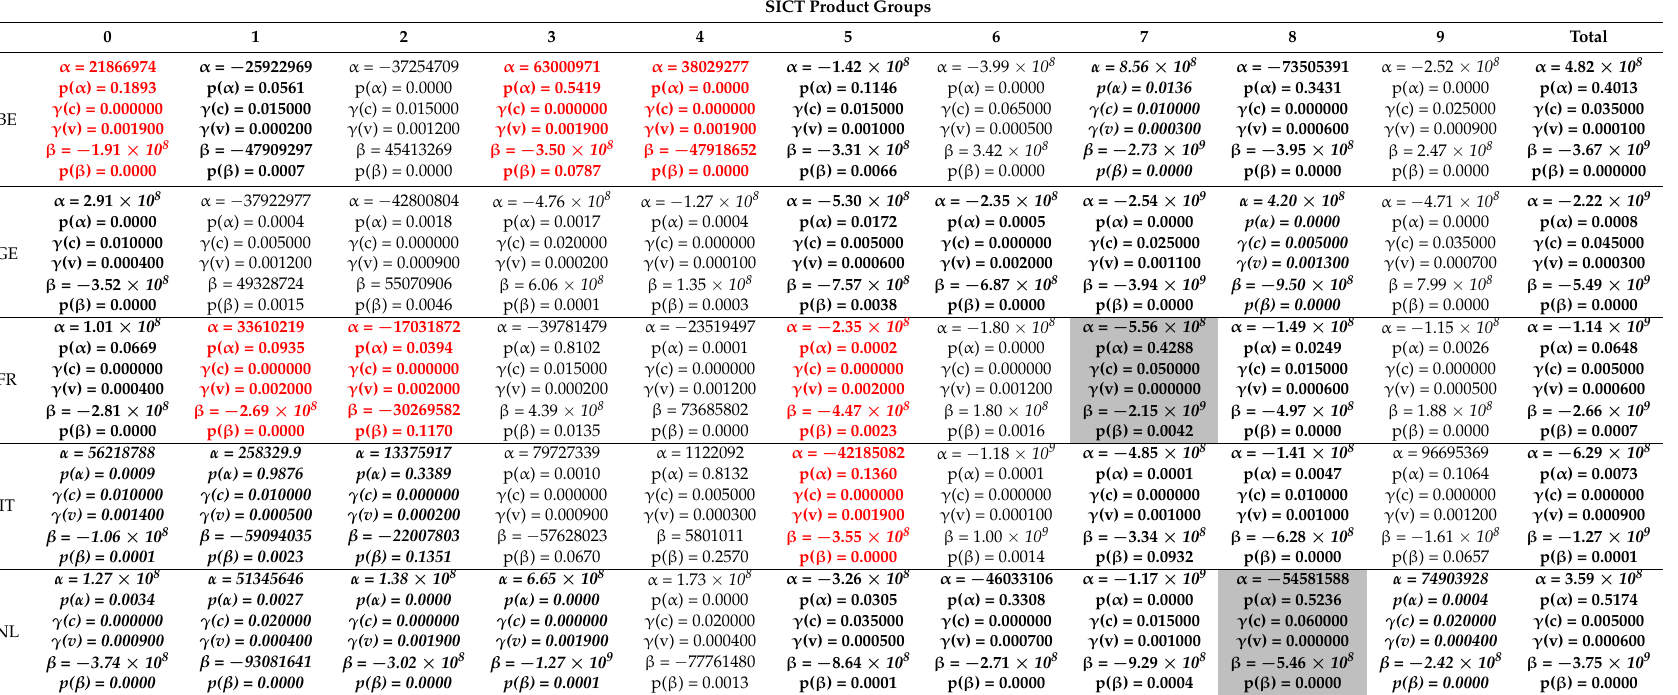
Table A3. Hysteresis with a variable play area (EPUI,